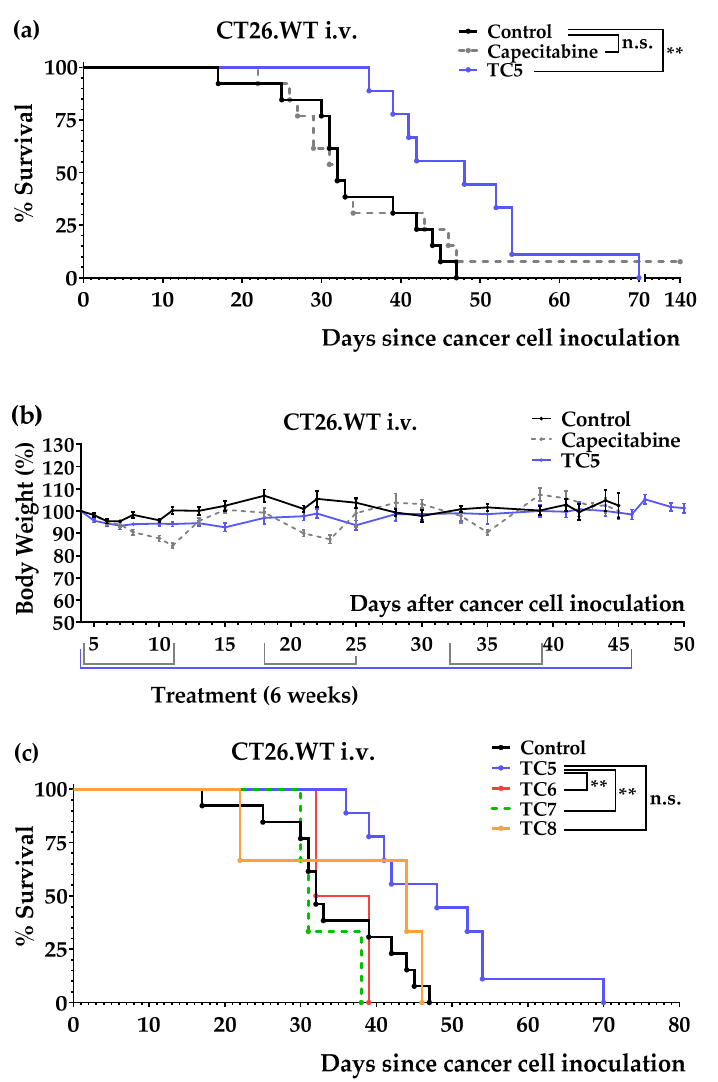
Figure 6. Anticancer activity of diets TC5, TC6, TC7, TC8, and capecitabine in mice with colon cancer (lung metastasis model; CT26.WT murine colon cancer cells inoculated in the tail vein of immunocompetent BALB/c mice). ( a ) Survival of the mice with colon cancer left untreated (control), treated with diet TC5 (6 weeks), or treated with capecitabine (450 mg/kg/day, 7/7 schedule, 3 cycles). ( b ) Body weights (mean percentage ± SEM) relative to the body weights of the mice at the beginning of treatment (day 4). ( c ) Comparison of survival of the mice fed for 6 weeks with diets TC5, TC6, TC7, and TC8. The p -values were calculated with the GBW test; ** indicates p < 0.01. n.s. means no